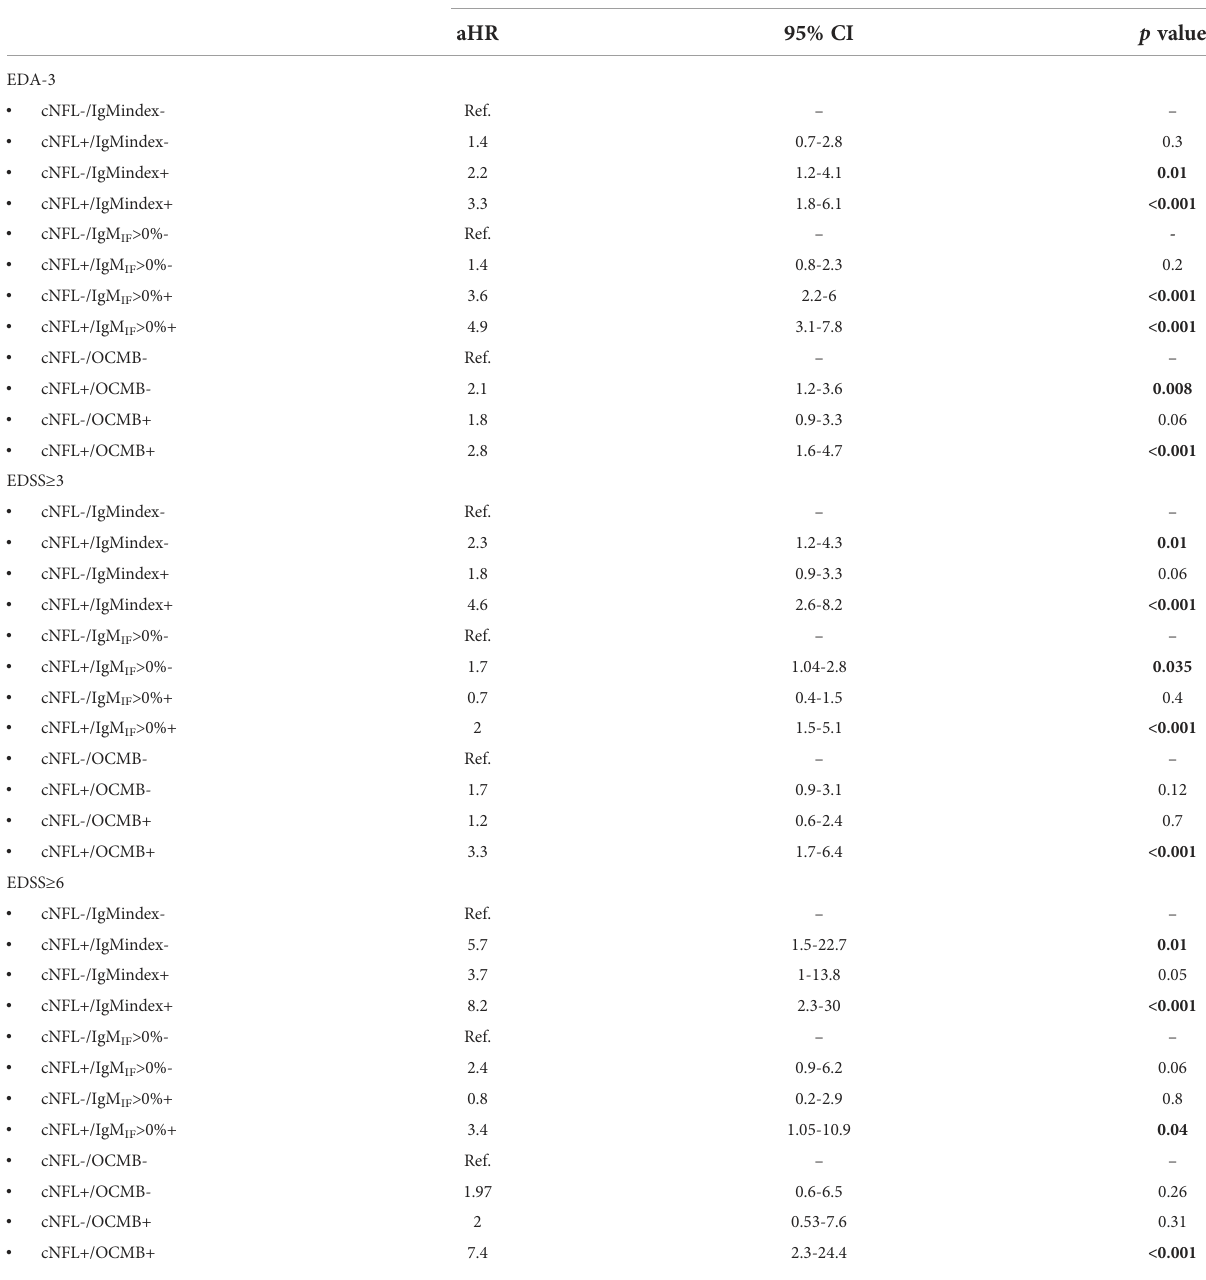
Cox proportional hazards